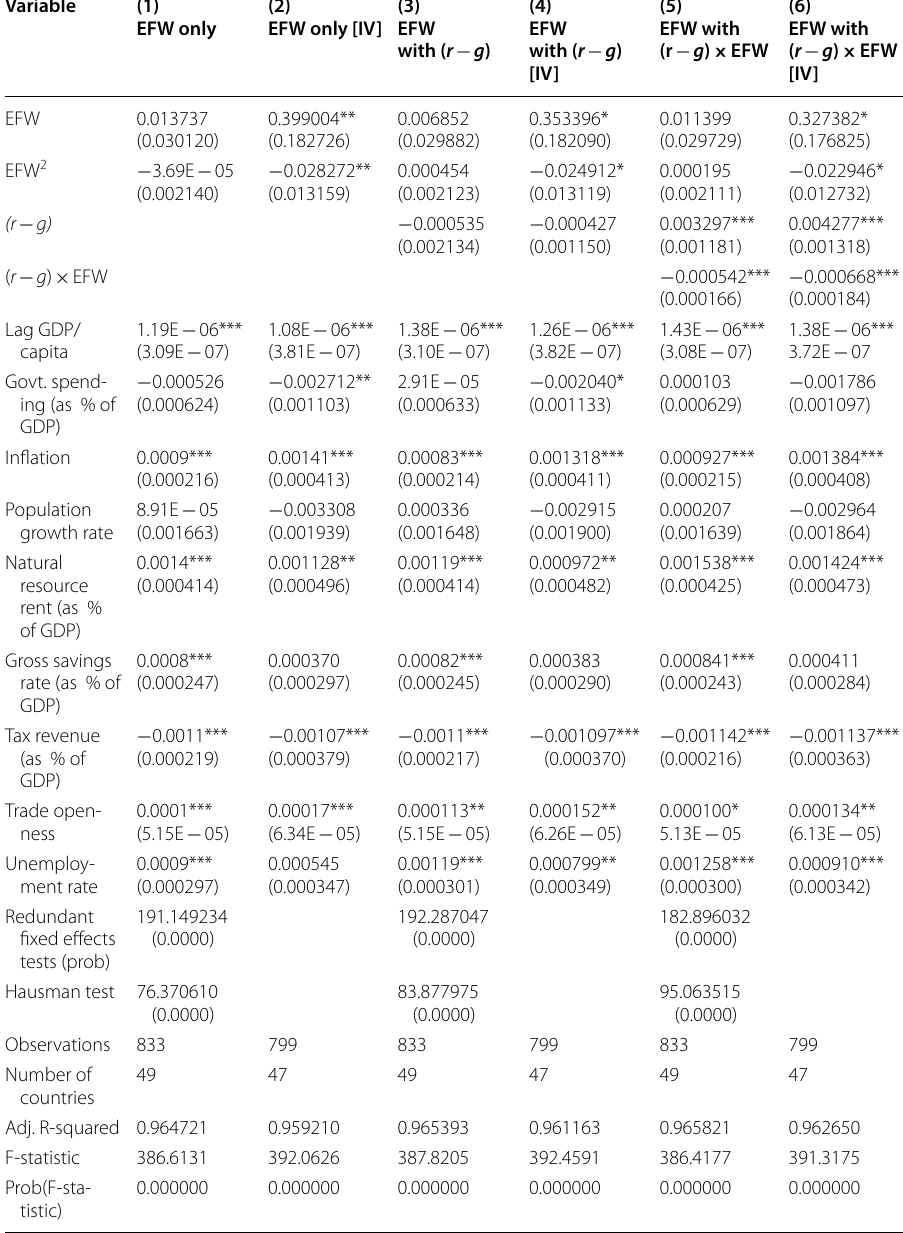
Table 5 Estimation results of top 10% income